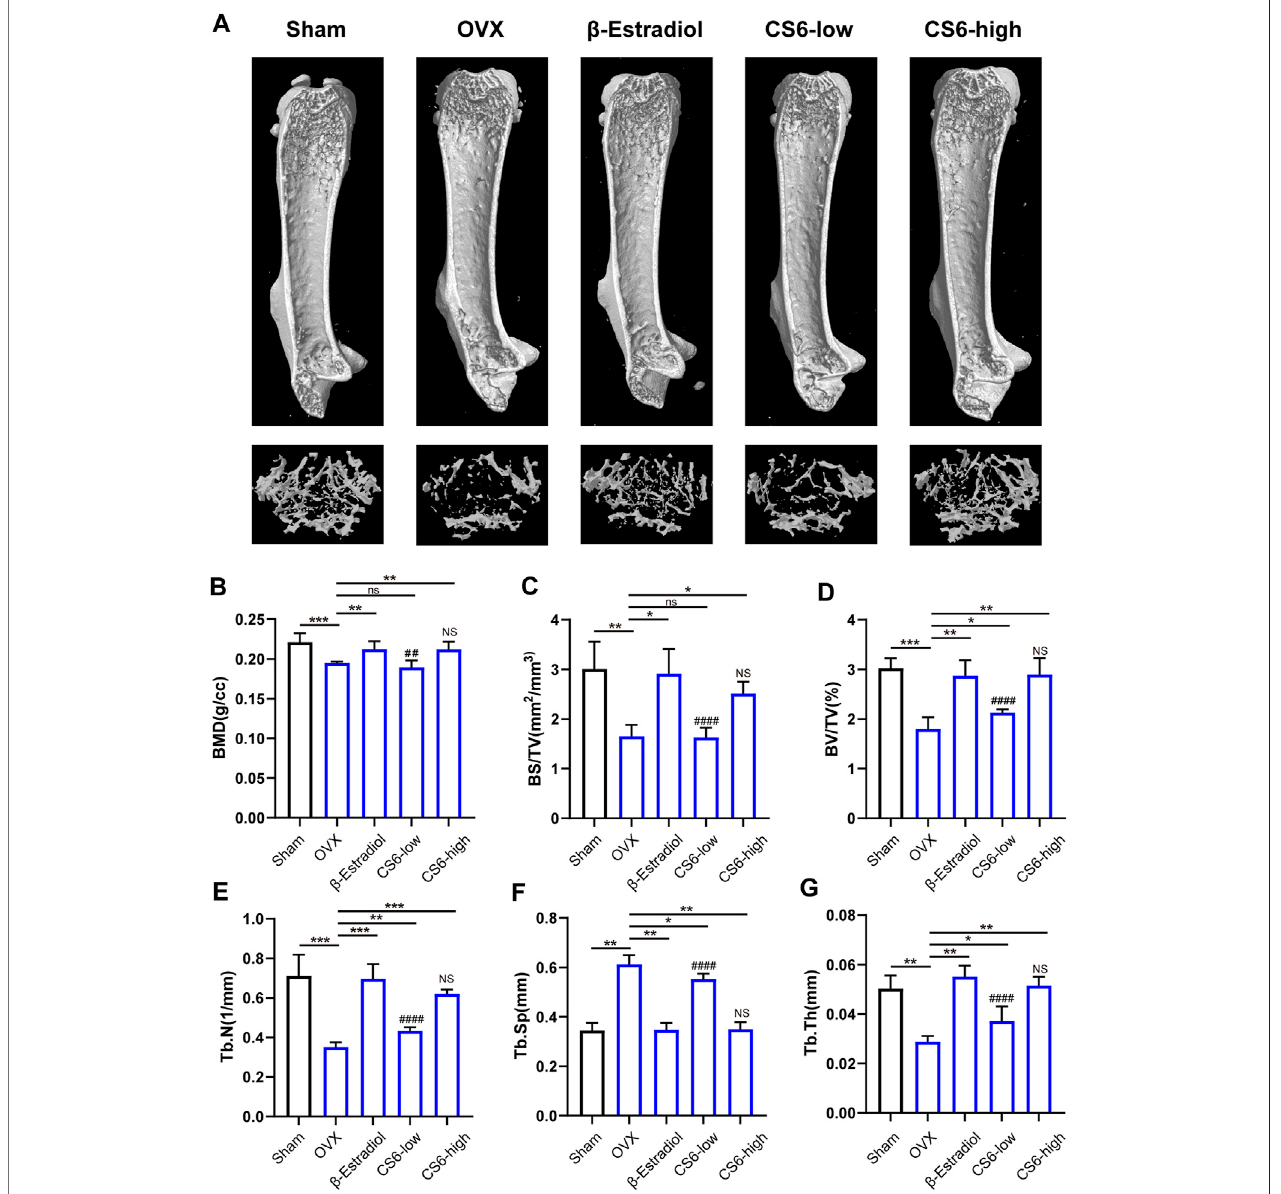
FIGURE 7 | Validation of the biological effect of CS-6 on osteoclastic bone resorption in systemic OVX-induced bone loss in vivo indicated by microstructure analysis. (A) Representativethree-dimensionalimagesof μ CTformousefemurfromtheshamgroup(mockoperationwithDMSOinjection),OVXgroup(OVXwithDMSO injection),positivegroup(OVXwith β -estradiolinjection,5 mg/kg),low-dosegroup(OVXwithlow-doseCS-6,0.5 mg/kg),andhigh-dosegroup(OVXwithhigh-doseCS- 6, 2.5 mg/kg). (B – E) Quantitative analyses of bone structural parameters, including trabecular bone mineral density (BMD, g/cc), bone surface area/total volume (BS/TV; %), bone volume/total volume (BV/TV; mm − 1 ), trabecular number (Tb.N; mm − 1 ), trabecular spacing (Tb.Sp, mm), and trabecular thickness (Tb.Th, mm) within the selected metaphyseal region were shown in the charts. Values were presented as the mean ± standard deviation ( n (cid:2) 5); * p < 0.05, ** p < 0.01, *** p < 0.001, **** p < 0.0001. # and NS indicated the comparison between the sham group and CS-6 treatment group, # p < 0.05, p < 0.01, p < 0.001, p <